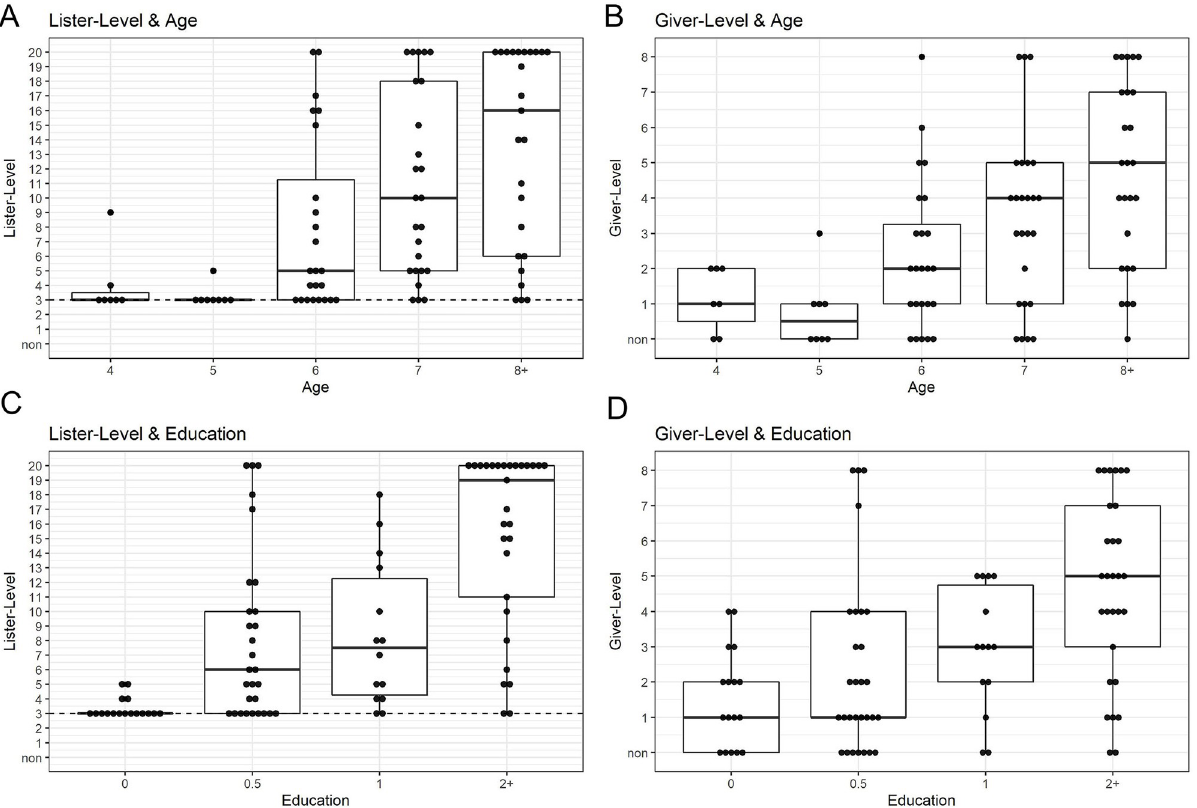
Fig 5. Lister and Giver-Levels by age and education. Increasing age and education are related to increasing Lister- and Giver- Levels. Because age and education are related, it is difficult to determine whether age, education, or both are independently driving Lister- and Giver- Level. However, it is likely that education is the primary catalyst for increasing Lister-and Giver- Level. (A) Lister-Level by age. Older children tend to have higher Lister-Levels than younger children. (B) Giver-Level by age. Older children tend to have higher Giver-Levels than younger children. (C) Lister-Level by education. Recall that children typically enter school at around 6–7 years old. Children with more formal education tend to have higher Lister-Levels. (D) Giver- Level by education. Children with more education tend to have higher Giver-Levels.